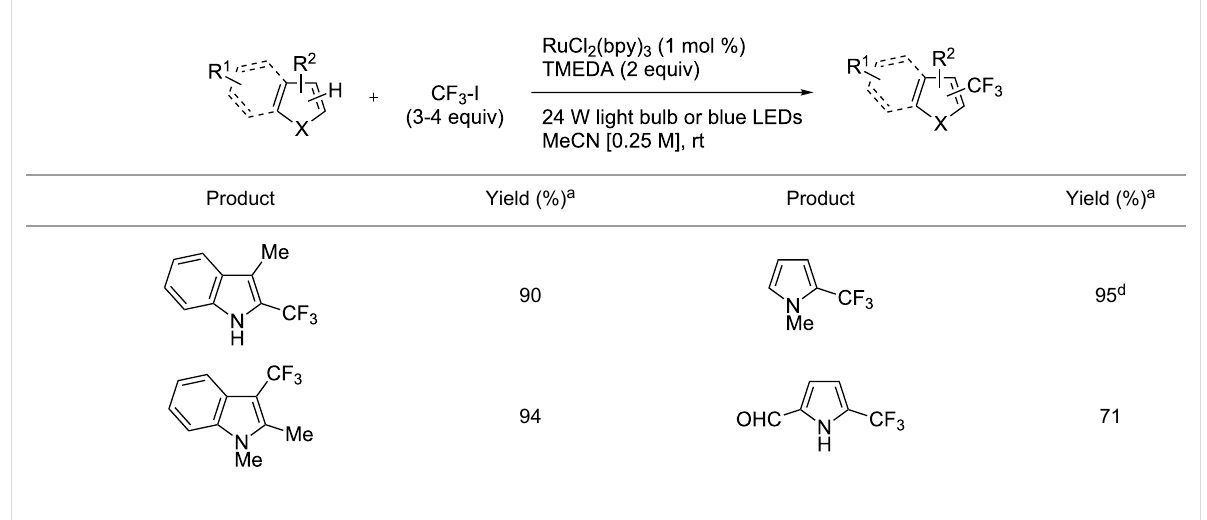
Table 33: Trifluoromethylation of indoles with trifluoromethyl iodide under Ru-based photoredox catalysis